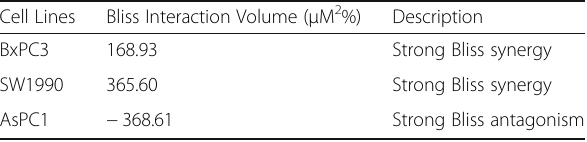
Table 3 Bliss Interaction Volume of Gemcitabine and SN Extracts Matrix Combination on PDAC Cell Lines Bliss Interaction Volume ( μ M 2